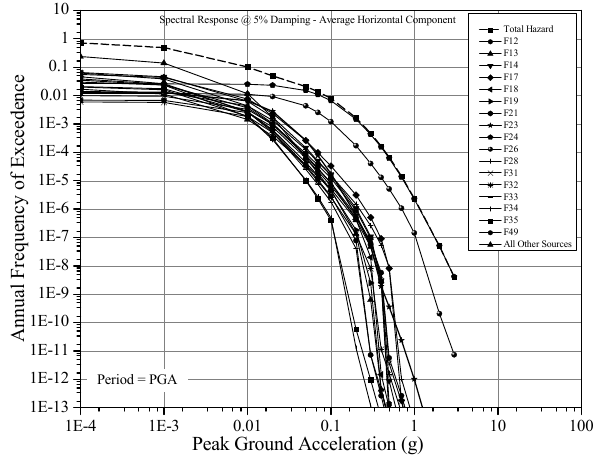
Figure 9. Total hazard for Ahmedabad city obtained from contribution of fault sources. 3 Fig. 9. Total hazard for the city of Ahmedabad obtained from the contribution of fault sources.